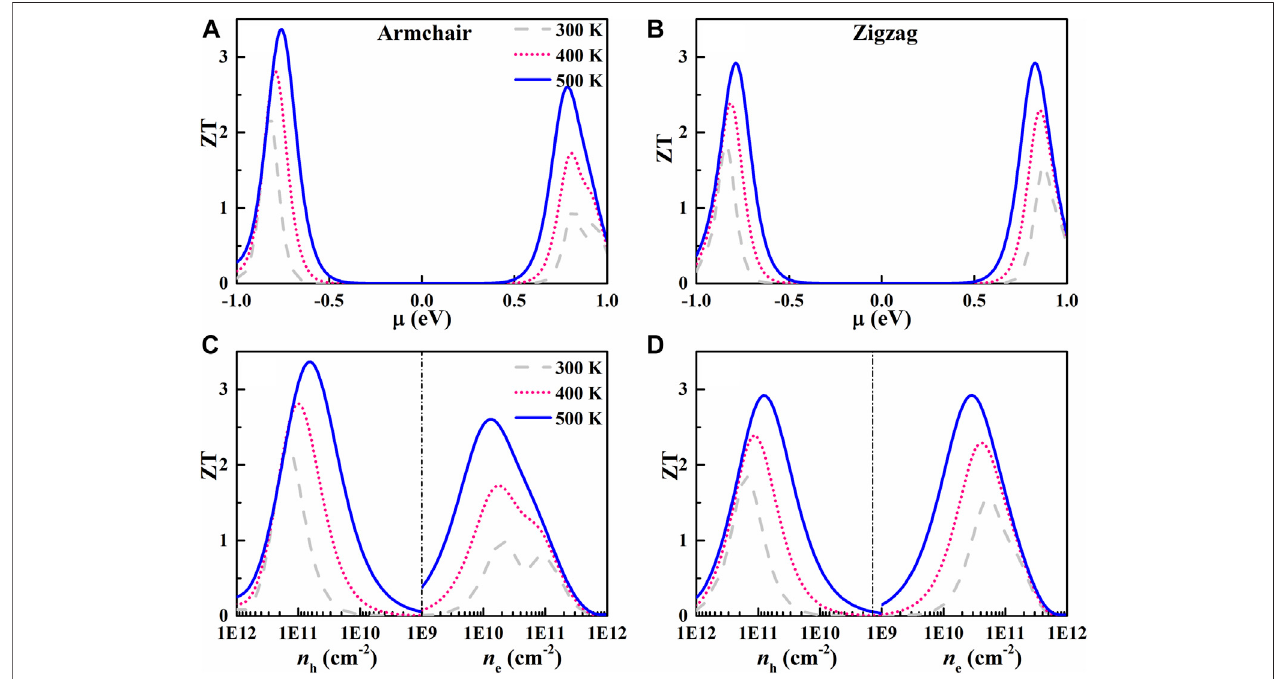
FIGURE 7 | ZT as a function of the chemical potential (A) and carrier concentration (B) of the AsP 3 monolayer.